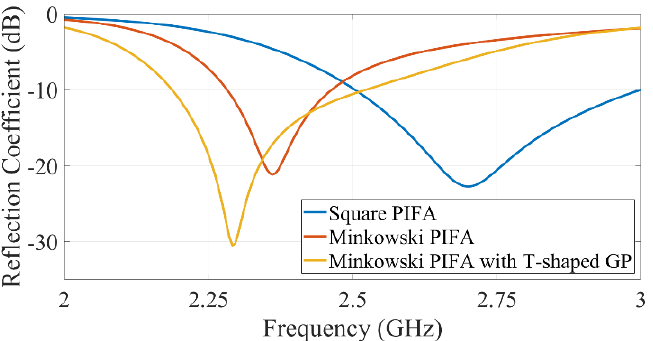
Figure 5. Simulated reflection coefficient for the Minkowski-pre-fractal-shaped PIFA (with and without T-shaped ground plane) compared to the original Square PIFA design.